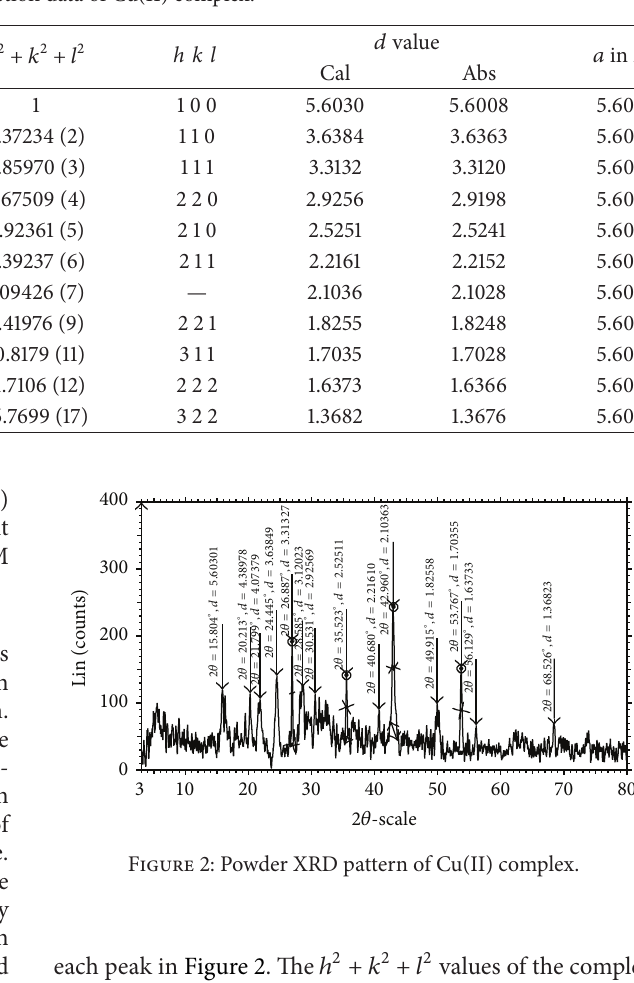
Table 5: X-ray diffraction data of Cu(II) complex.